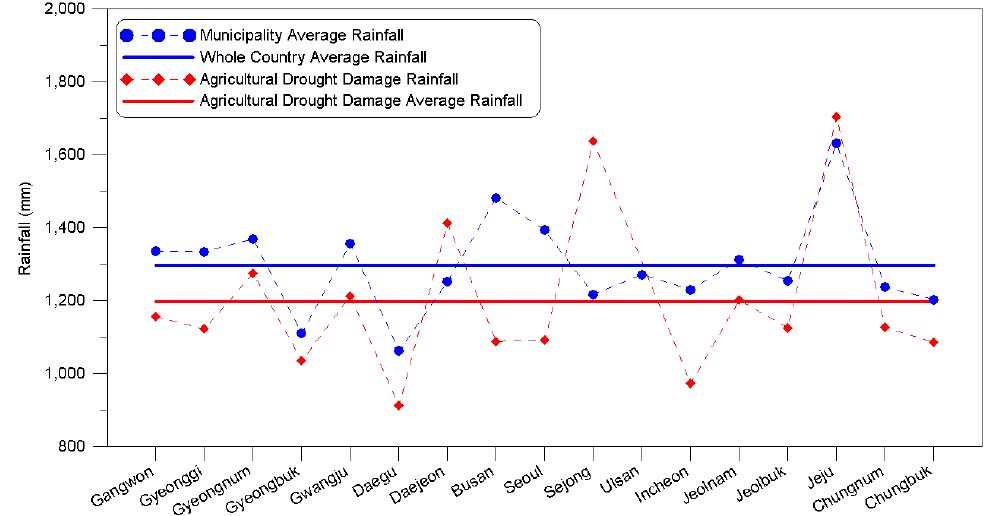
Figure 7. Setting up rainfall for disaster prevention relevant to agricultural droughts by municipality.